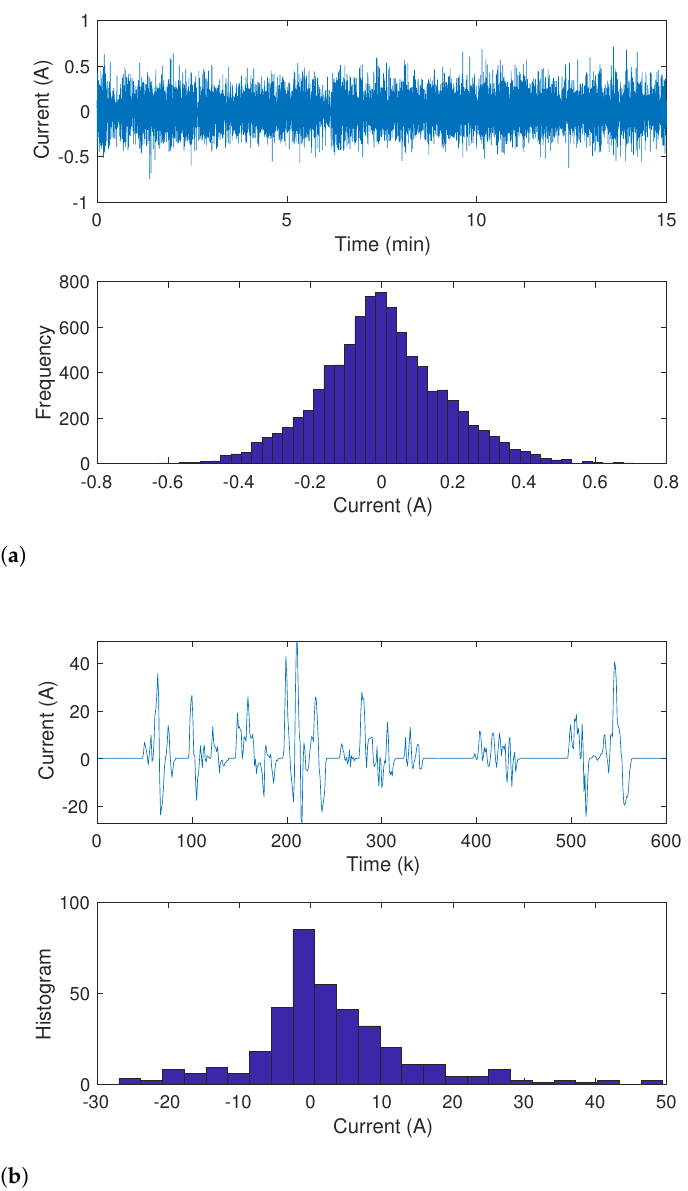
Figure 2. Current difference in realistic loads. ( a ) Smart Phone [15], σ L = 0.1673A,C batt = 1.5 Ah and ( b ) Electric Vehicle [9], σ L = 8.6917A,C batt ≈ 250